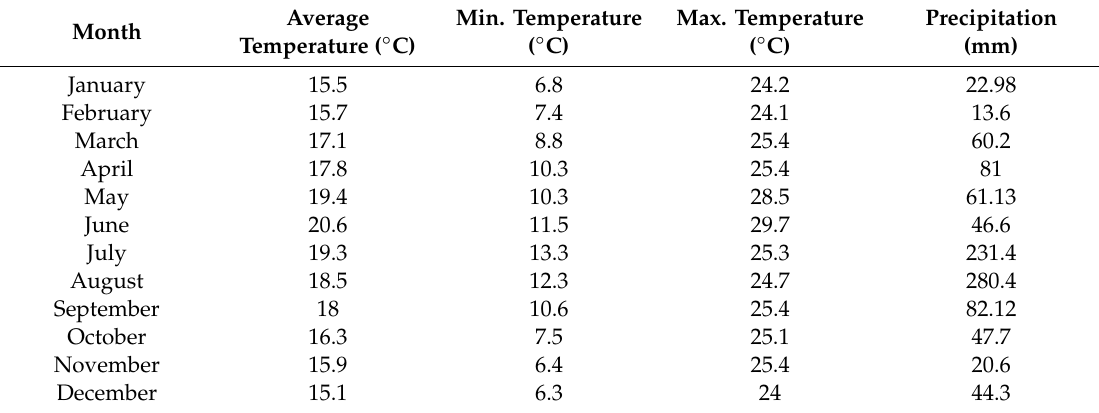
Figure 1. Digital elevation model of the study area and stream network of the dry Afromontane forest landscape in northern Ethiopia. Table 1. Mean climate data from 1981–2018 years of the study area.